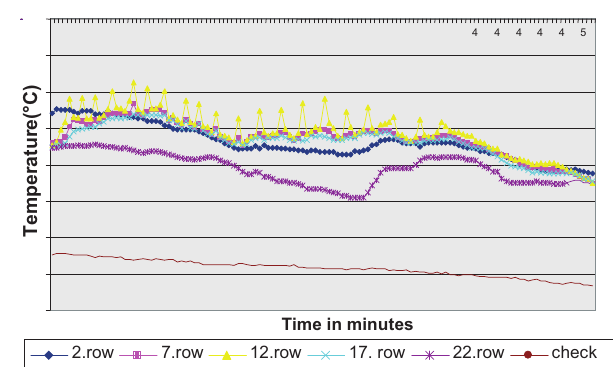
Figure 4. The movement of the Frostbuster, to and fro, in the 12 th row extended its effect to the whole plantation treated. /Siófok, 2011. Febr.